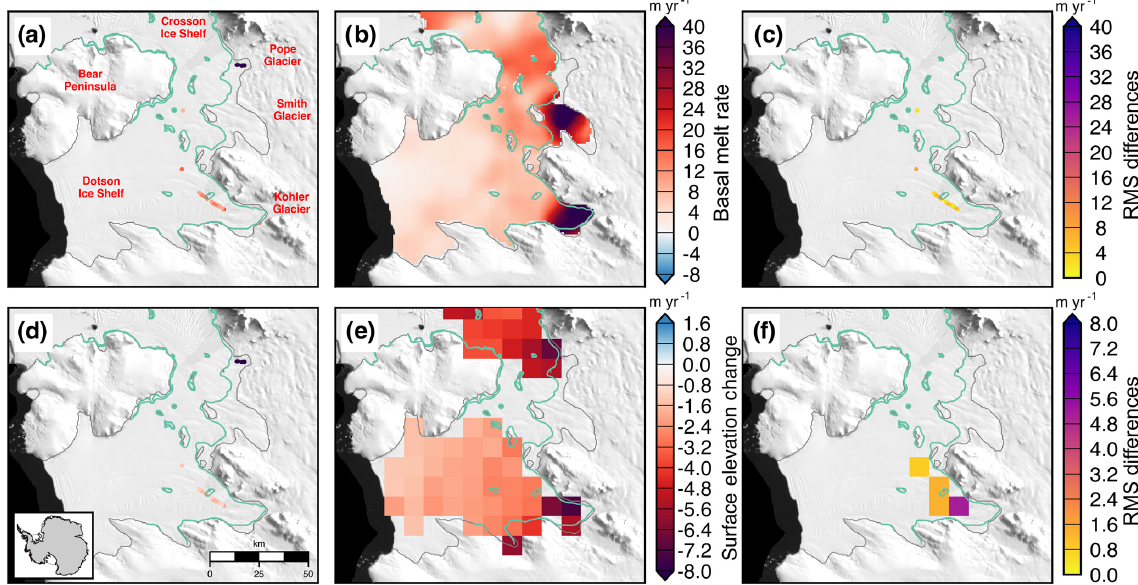
Figure 12. Estimated basal melt rates (a–b) and differences in melt rates (c) of the Dotson and Crosson ice shelves from (a) NASA– CECS Pre-IceBridge and NASA Operation IceBridge over 2002–2009 and (b) from ICESat over 2003–2009 (Rignot et al., 2013). Estimated elevation change rates (d–e) and differences in elevation change rates (f) of the Dotson and Crosson ice shelves from (d) NASA–CECS Pre-IceBridge and NASA Operation IceBridge over 2002–2009 and (e) from ICESat over 2003–2009 after correcting for strain (Pritchard et al., 2012). MEaSUREs InSAR-derived Antarctic grounded ice boundaries are denoted in gray (Mouginot et al., 2017b). The 1996 InSAR- derived grounding line locations from Rignot et al. (2016) are delineated in green. Plots are overlaid on a 2008–2009 MODIS mosaic of Antarctica (Haran et al., 2014). The inset map denotes the location of the